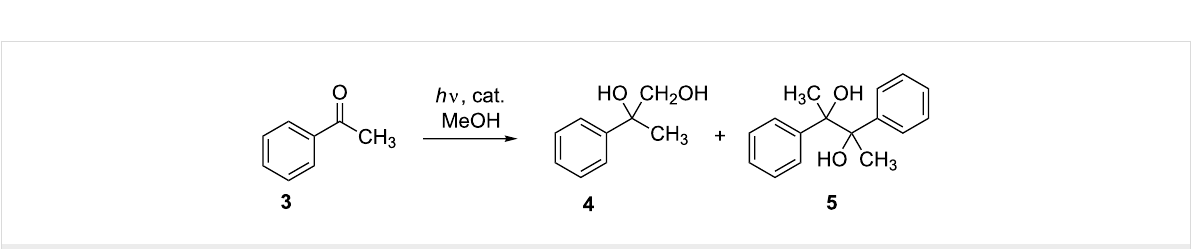
Scheme 5: Model reaction for heterogeneous and dye-sensitized